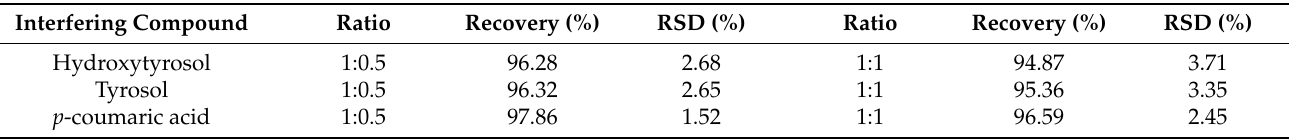
Table 5. OLEU results in the presence of interfering